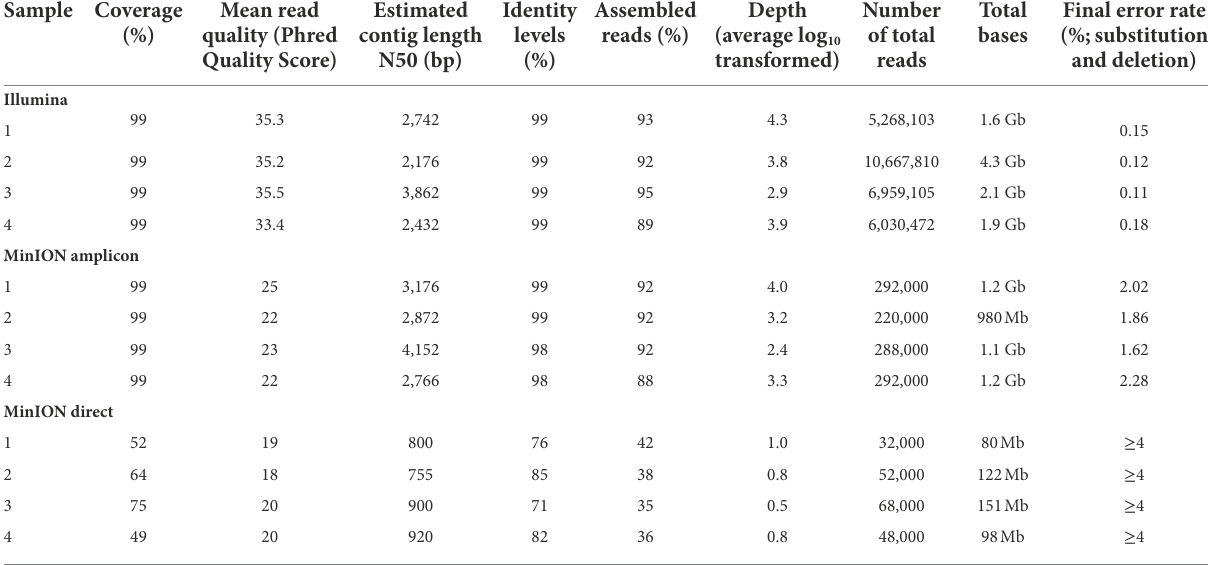
TABLE 3 Comparison of the most important whole-genome sequencing quality parameters in Illumina, MinION amplicon, and MinION direct. Sample Coverage